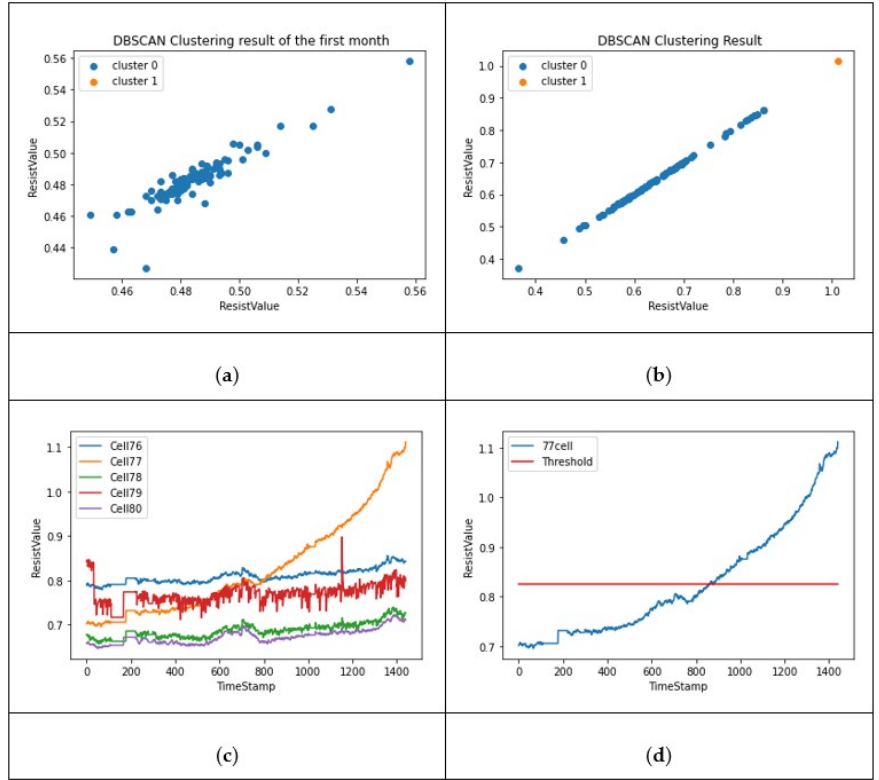
Figure 6. ( a ) Each cell positioned before clustering; ( b ) clustered cells result; ( c ) indicates the trend of resist value from cells 76~80; ( d ) indicates resist value trend for cell 77.